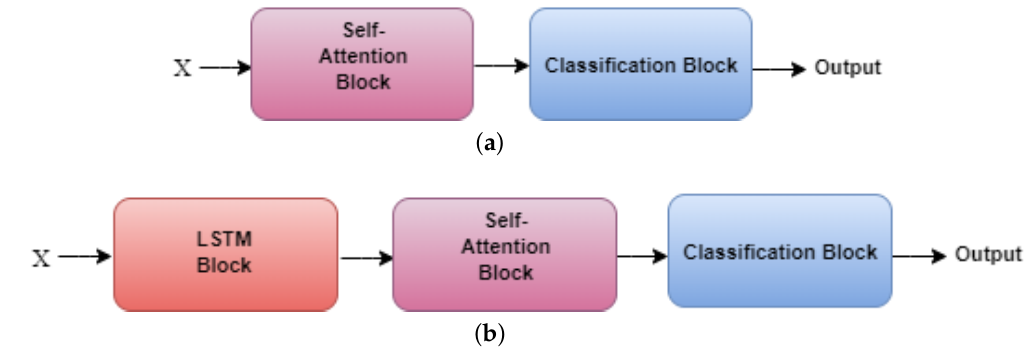
Figure 7. Architecture of the proposed methods. ( a ) Self-attention-based neural network for PRPDs (SANPD). ( b ) Long short-term memory SANPD (LSANPD).